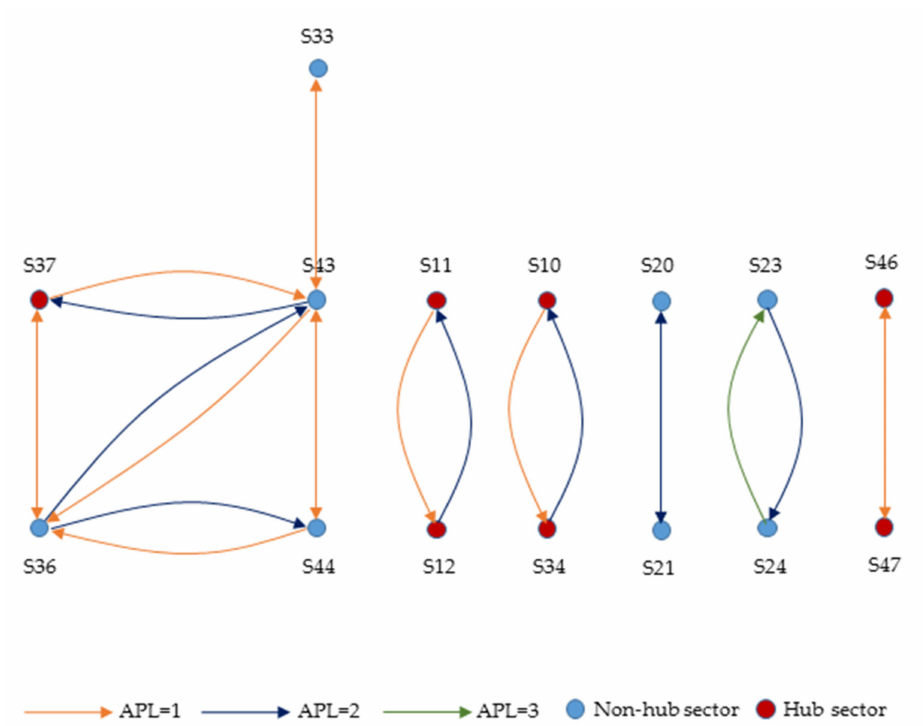
Figure 4. The hub wastewater propagation chains that APL-HCG selected in 2017. The orange, dark blue and green edges mean that their APL value is 1, 2 and 3, respectively. Each vertex on figures stands for a sector explained in Appendix B. Dark red nodes indicate sectors that densely surround many linkages with a considerable degree of closeness to their linked sectors. The blue nodes imply that there are no surrounding dense linkages in the results.